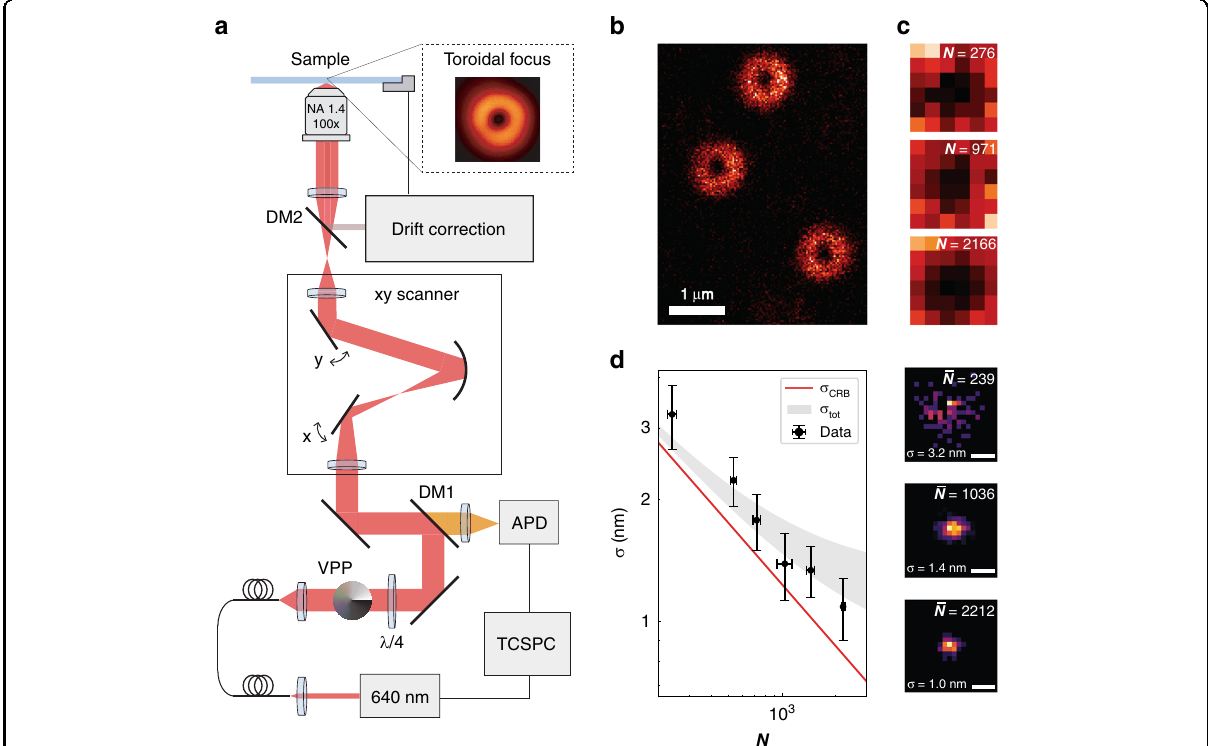
Fig. 2 Experimental implementation in a confocal microscope. a Schematic representation of the optical setup used to perform RASTMIN. The setup is based on a standard home-built confocal microscope with an optical scanner. A vortex-phase plate in the excitation path and a drift correction system were added. The inset shows an image of the experimentally obtained toroidal focus. b Confocal image overview of the sample containing individual DNA origami with one fl uorescent molecule each. c Exemplary RASTMIN frames obtained at different laser powers (3, 12, and 24 µW). The RASTMIN parameters were K = 6 × 6, L = 100 nm, frame time was 130 ms, and SBR was 4. d Localization precision achieved in RASTMIN measurements on single molecules (ATTO647N) with different photon counts. For each condition ( N ), three independent measurements were carried out, each one consisting of 100 localizations. For comparison, the theoretical σ CRB ( N ) (solid line) and the predicted localization uncertainty for the ffiffiffiffiffiffiffiffiffiffiffiffiffiffiffiffiffiffiffiffiffiffi p σ 2 þ σ 2 , gray shaded area) are shown for σ DC = 0.8 – 1.3 nm. The theoretical σ CRB ( N ) was calculated in the central 10-nm experiments ( σ TOT ¼ DC CRB part of the FOV. On the right, exemplary 2D histograms of localizations with average photon counts of N ¼ 239 ; 1036 ; and 2212. The corresponding localization uncertainties ( σ ¼ 3 : 2 ; 1 : 4 ; and 1 : 0 nm) are also displayed. Scale bar in d : 5